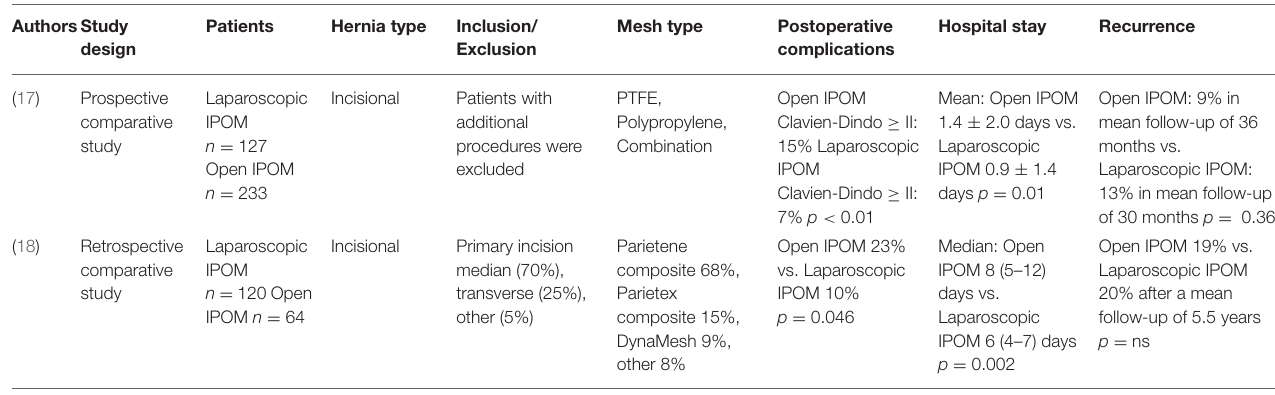
TABLE 1 | Laparoscopic vs. open intraperitoneal onlay mesh for incisional hernia